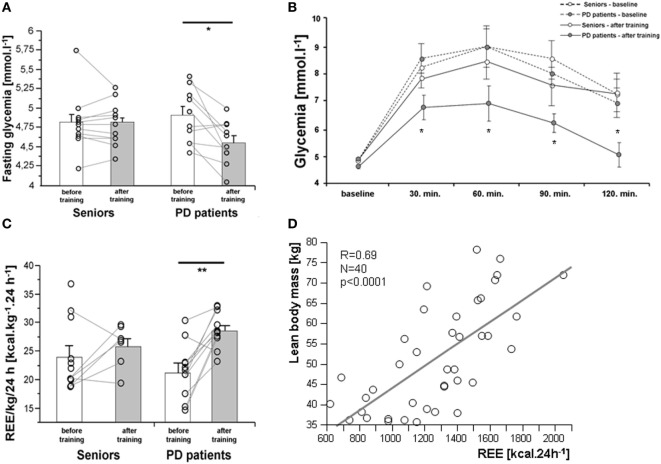
Effects of a 3-month combined endurance/strength training on fasting glycemia (A), glycemic curve [oral glucose tolerance test, (B)], and REE (C). REE was associated with muscle mass in the entire study population (D). Data are expressed as average ± SEM, *p < 0.05, †p < 0.1; REE, resting energy expenditure; LBM, lean body mass; PD, Parkinson’s disease.